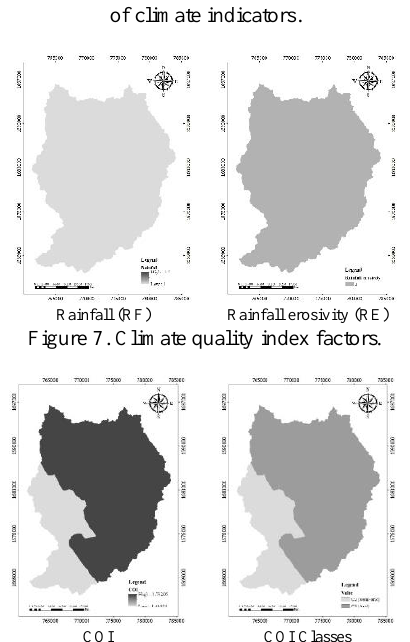
Figure 8. The distribution of climate quality index classification.